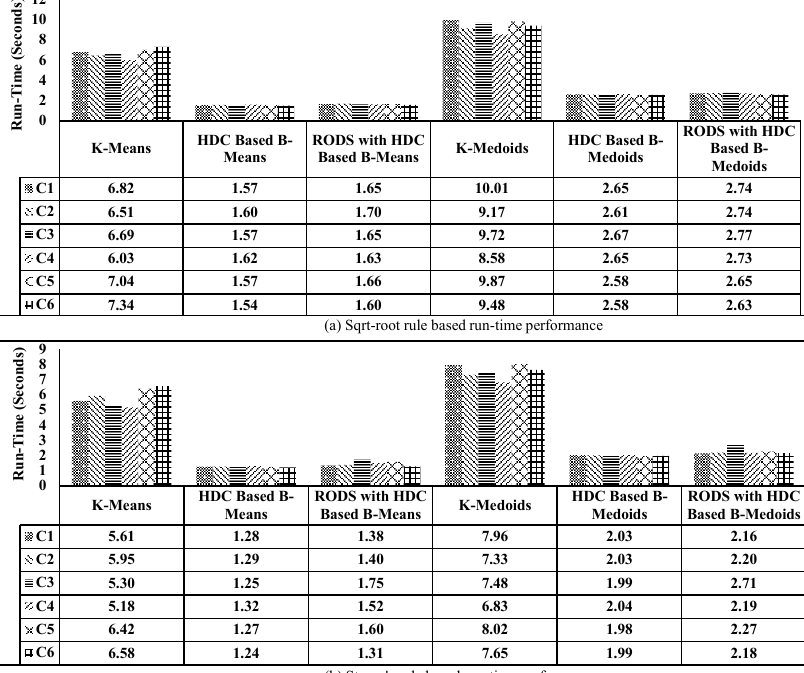
Figure 23. Run-time analysis for square-root and Sturge’s